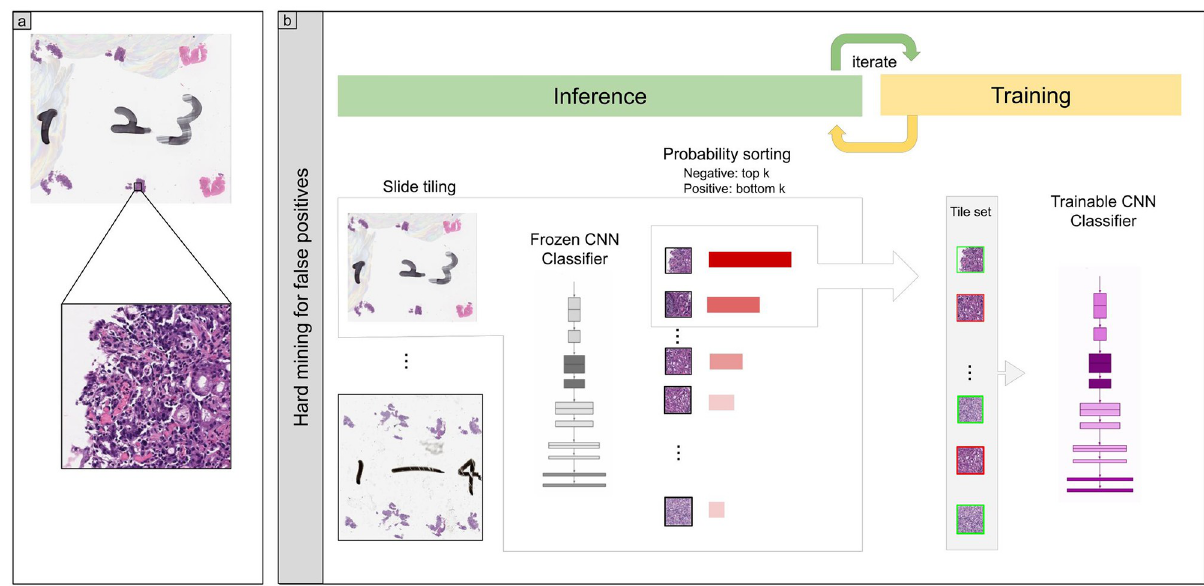
Fig 1. Overview of training method. (a) shows a zoomed-in example of a tile from a WSI. (b) During training, we alternated between an inference step and a training step. During the inference step, the model weights were frozen and the model was used to select tiles with the highest probability after applying it on the entire tissue regions of each WSI. The top k tiles with the highest probabilities were then selected from each WSI and placed into a queue. During training, the selected tiles from multiple WSIs formed a training batch and were used to train the model.